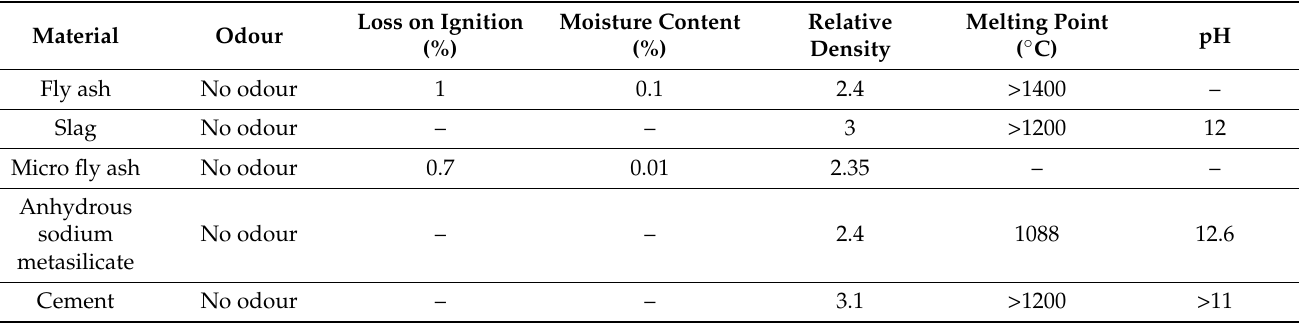
Figure 3. Lysaght dovetailed profiled sheet (dimensions are in mm). ( a ) 3D section. ( b ) cross-section. Table 1. Physical properties of concrete